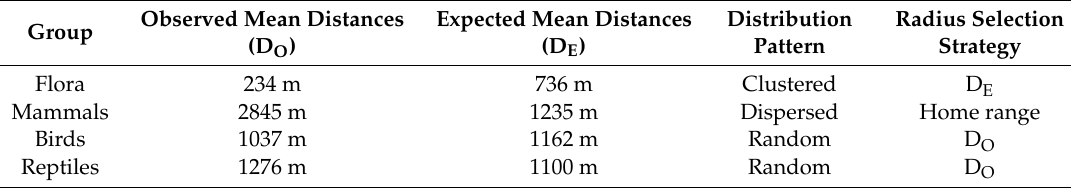
Table 4. The results of average nearest neighbor (ANN) analysis applied to the point locations of specie groups.